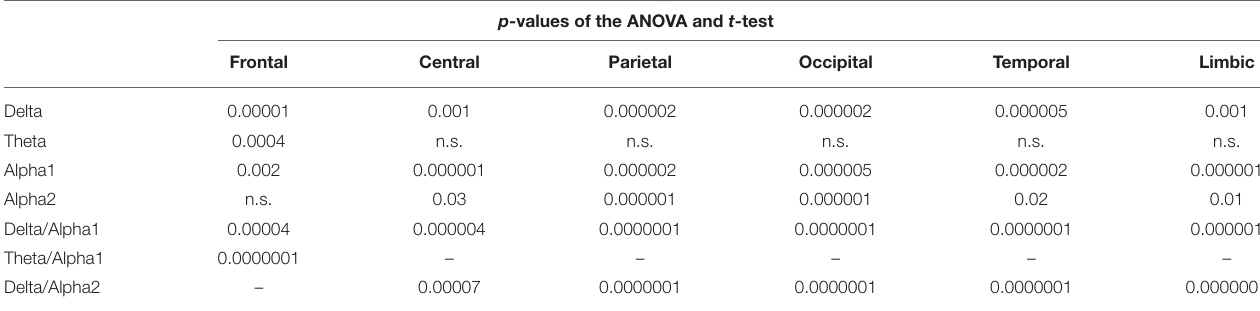
TABLE 3 | P -values (Duncan post-hoc ) of the ANOVA related to the comparisons of source activity showing a statistically significant interaction [ F (30 , 6540) = 18.727 , p < 0.0001] among the factors Group (AD, Nold), Band (delta, theta, alpha 1, alpha 2, beta 1, beta 2, gamma), and ROI (central, frontal, parietal, occipital, temporal, limbic) and p -values of the t -tests for each composite EEG marker. p -values of the ANOVA and t -test Frontal Central Parietal Occipital Temporal Limbic 0.00001 0.001 0.000002 0.000002 0.000005